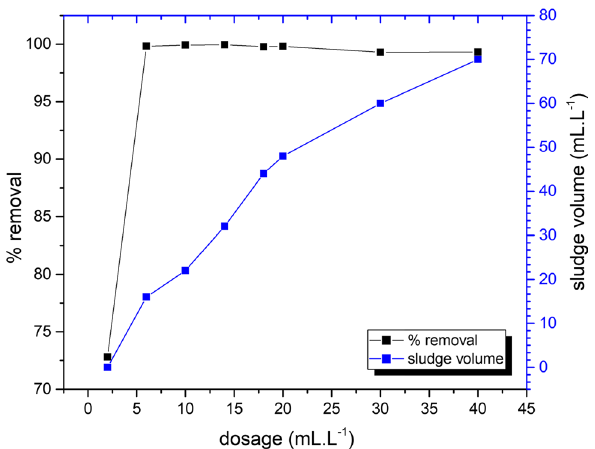
Fig. 3 Effect of dosage (at pH 3) on % removal and sludge volume Table 2 Comparison of leucaena seed kernel extract vs alum performance in coagulating Congo